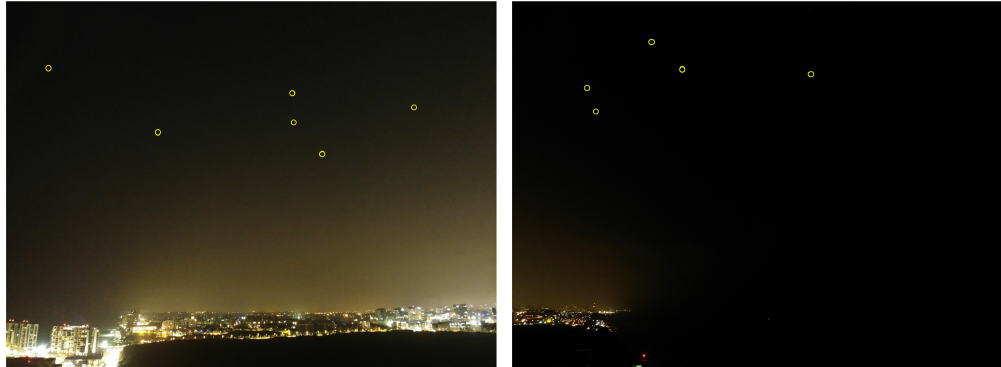
Figure 18. Star detection frames taken from a Mavic Pro drone. The stars can clearly be identified from these video-frames. The star tracking algorithm can serve as another sensor for detecting the drone orientation (especially when the GPS signal is